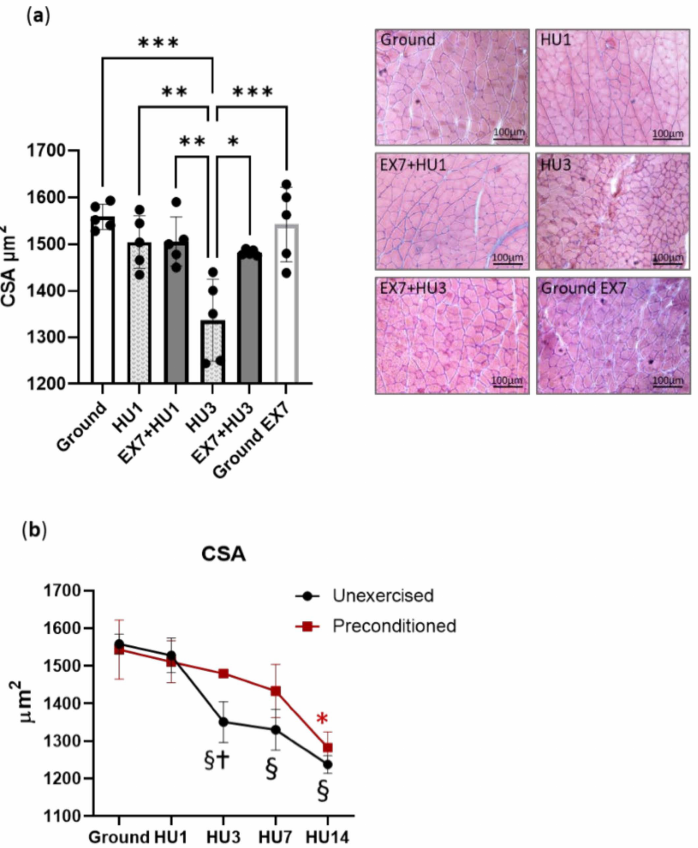
Figure 2. Physical preconditioning mitigates disuse-induced atrophy of gastrocnemius. Cross Sectional Area (CSA) of gastrocnemius muscle fibers of mice subjected to disuse alone and preceded by physical preconditioning and representative hematoxylin–eosin staining; scale bars: 100 µ m ( a ). CSA time course changes with disuse alone and preceded by 7 days of physical preconditioning ( b ). Ground: Control mice ; HU1, HU3, HU7, and HU14: Mice subjected to 1, 3, 7, and 14 days of hindlimb unloading; Ground EX7: Mice subjected to 7 days of physical exercise. Data are presented as means ± SD * p < 0.05 ** p < 0.005 *** p < 0.0005. §: Different from ground and unexercised HU1 groups; †: Different from preconditioned HU3 group; ∗ : Different from ground and preconditioned HU1 and HU3